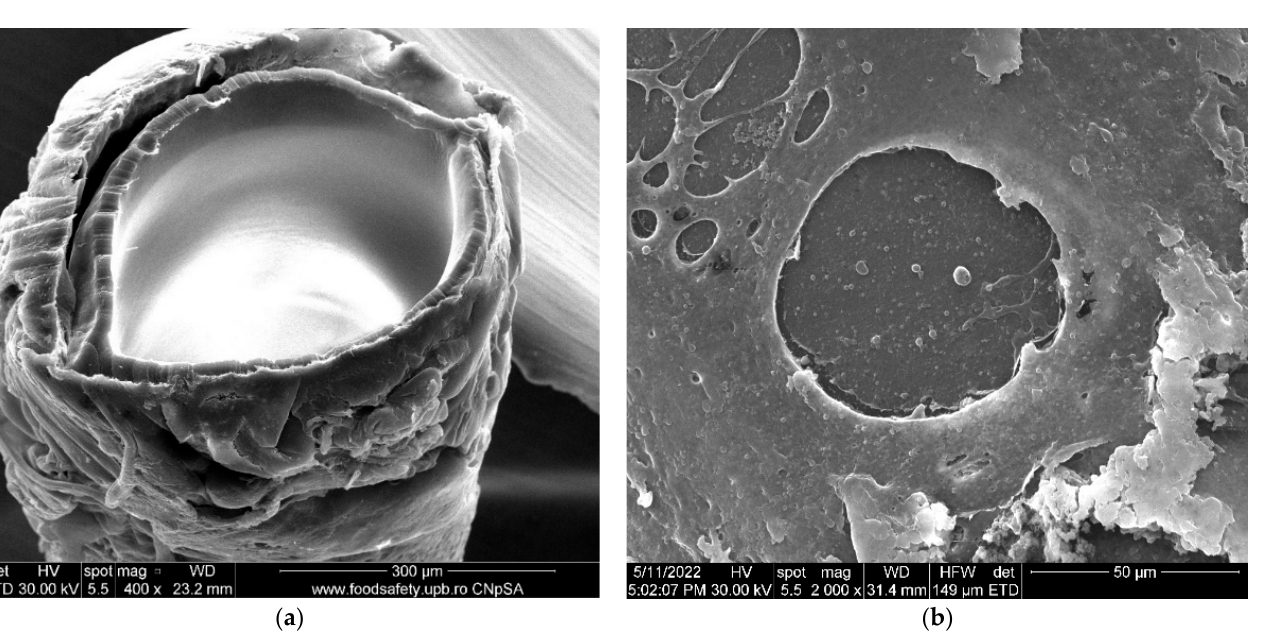
Figure 16. Scanning electron microscopy (SEM) for repeatedly used membranes: (a) section; and (b) surface.